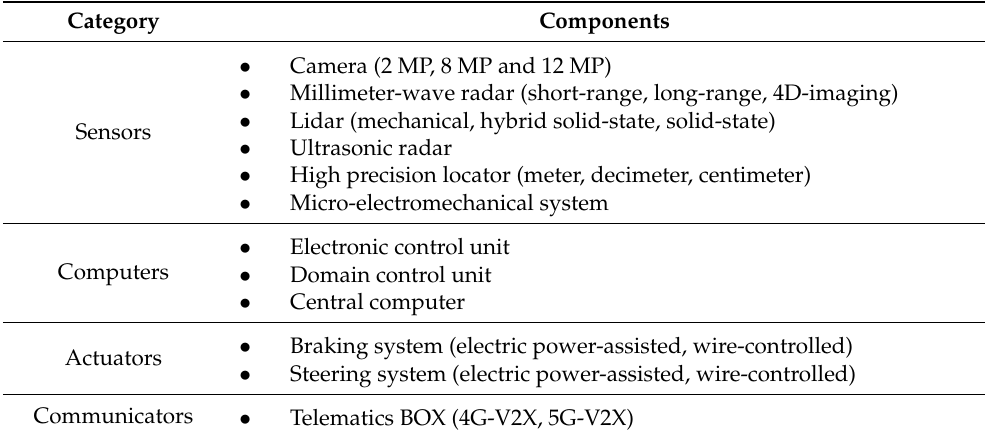
Table 1. Technical components of intelligent driving.